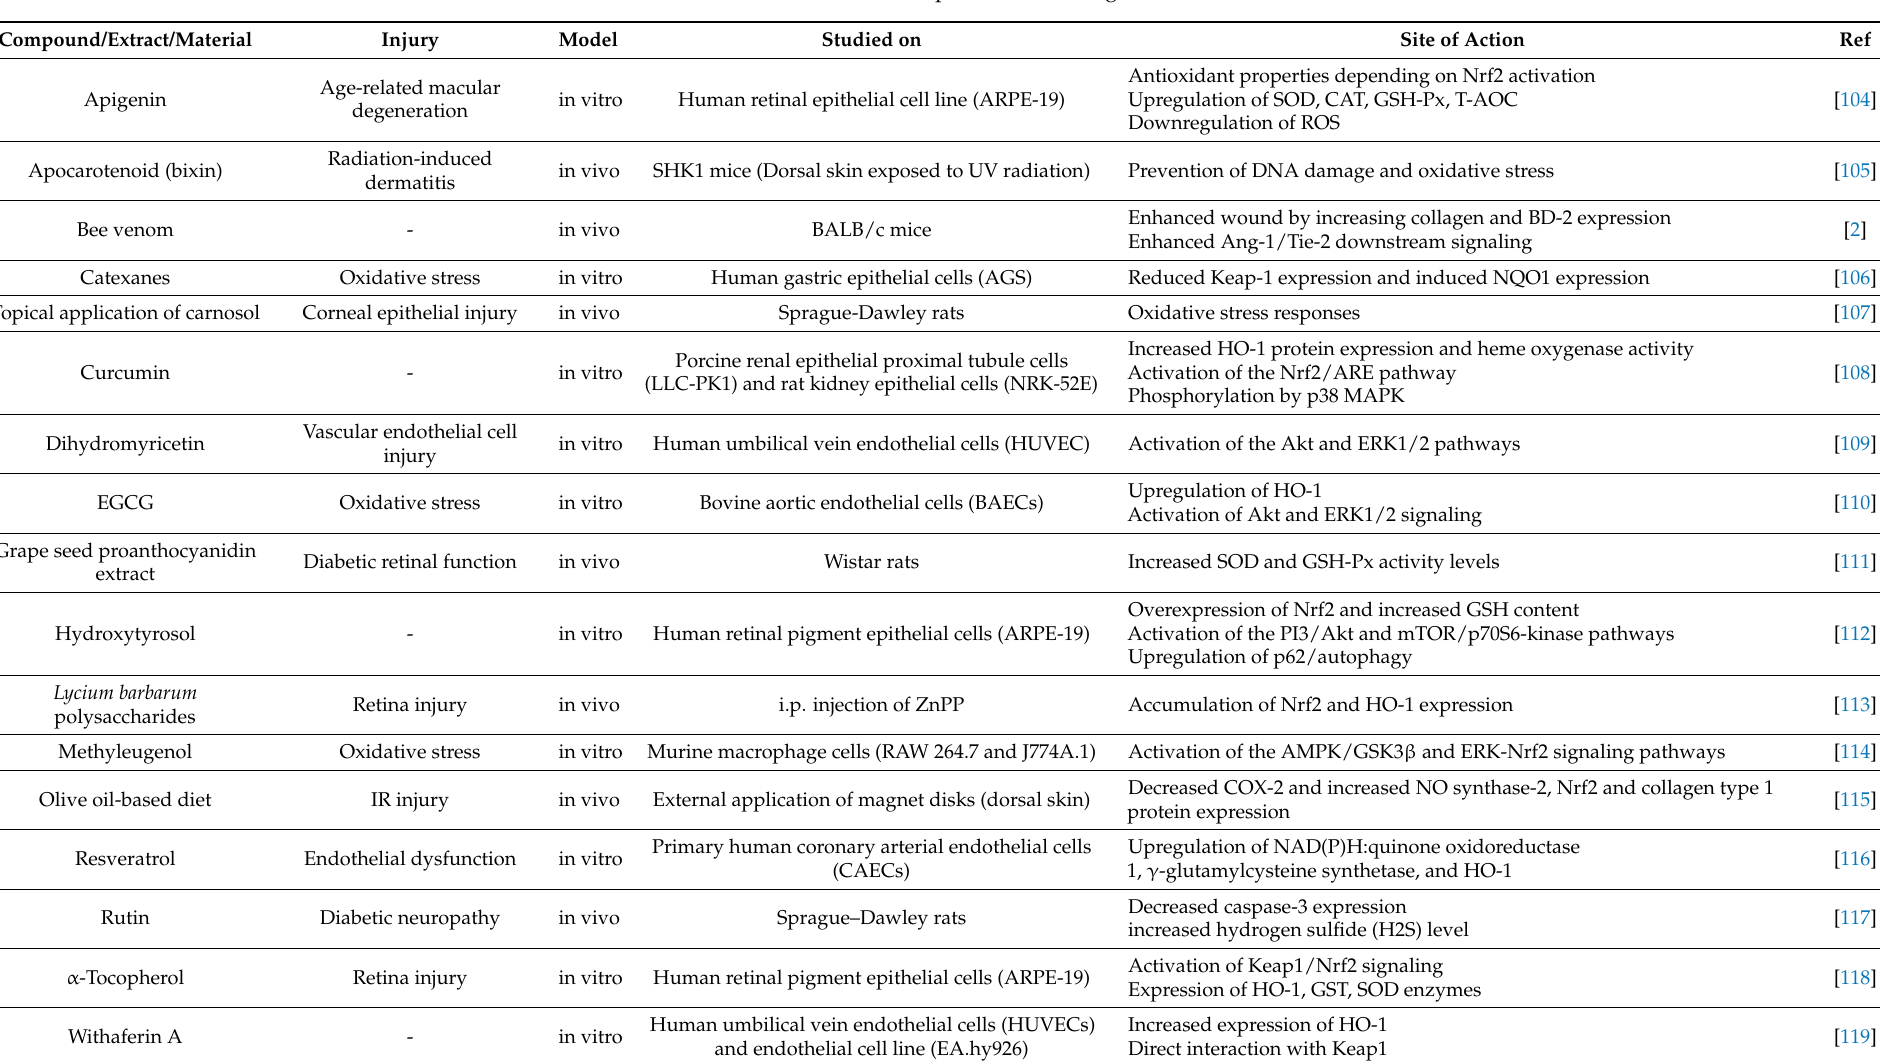
Table 2. Recent studies on natural products inducing Nrf2